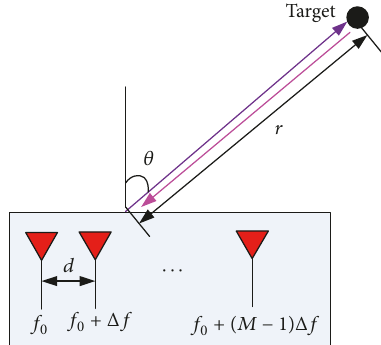
Figure 1: Sketch of FDA-MIMO radar with one single